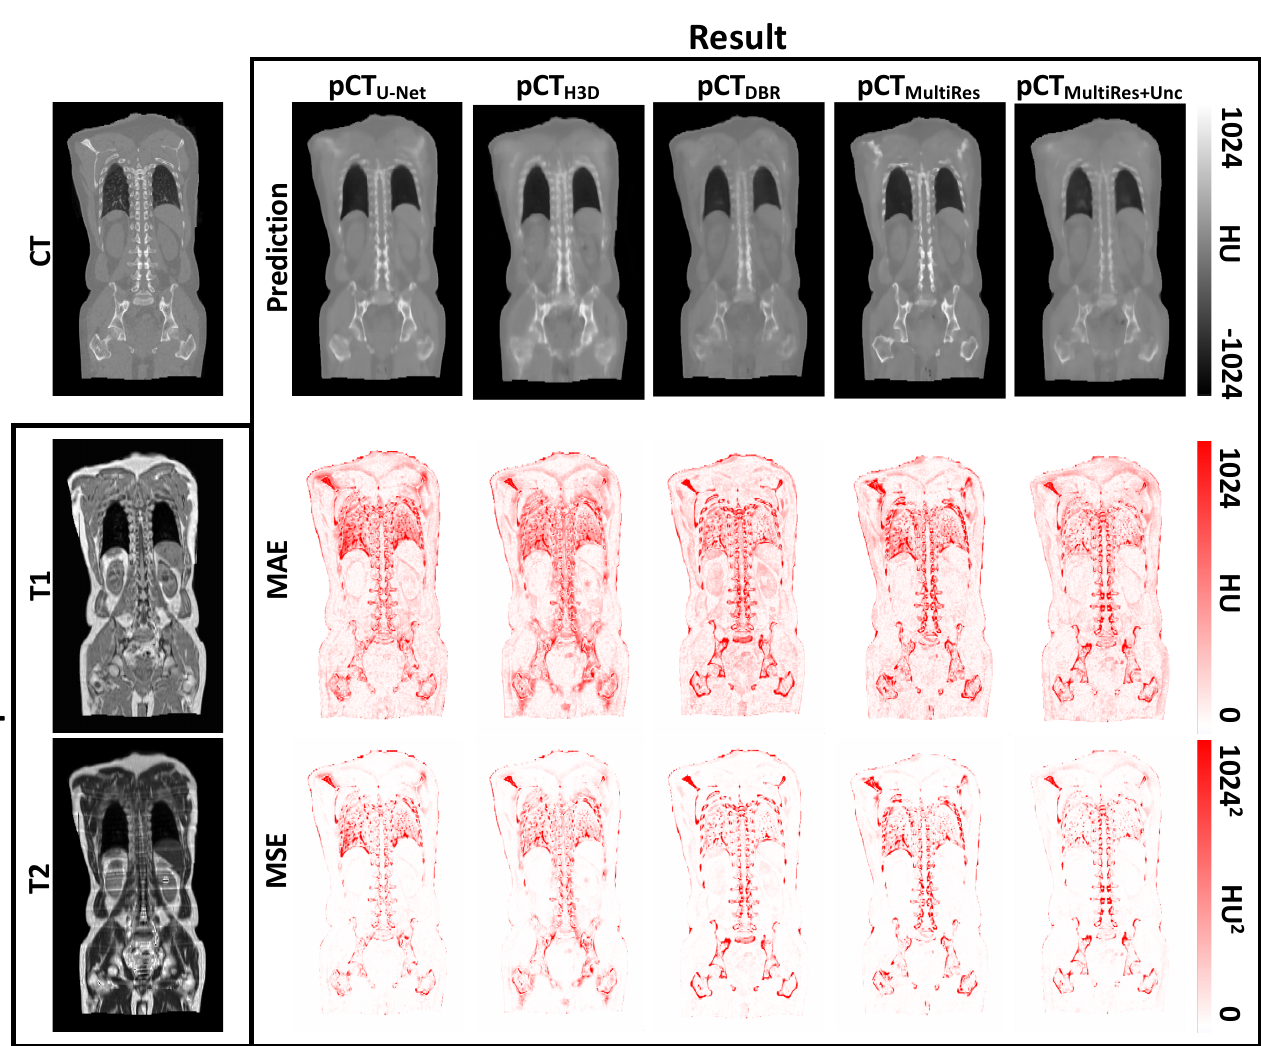
Figure 2. Ground truth CT and input T 1 − and T 2 − weighted MR images (first column) followed by predicted pseudo CT images with corresponding Mean Absolute Error (MAE) and Mean Squared Error (MSE) for 3D U-Net, HighRes3DNet, Deep Boosted Regression, MultiRes without uncertainty and MultiRes unc including uncertainty